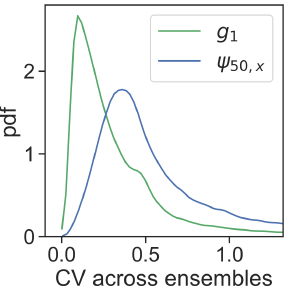
Figure 4. Empirical distribution across pixels of the coefficient of variation (CV) of g 1 and ψ 50 , x calculated across